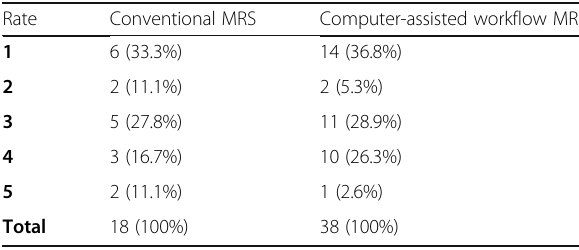
Table 4 Results of spectral quality rating Rate